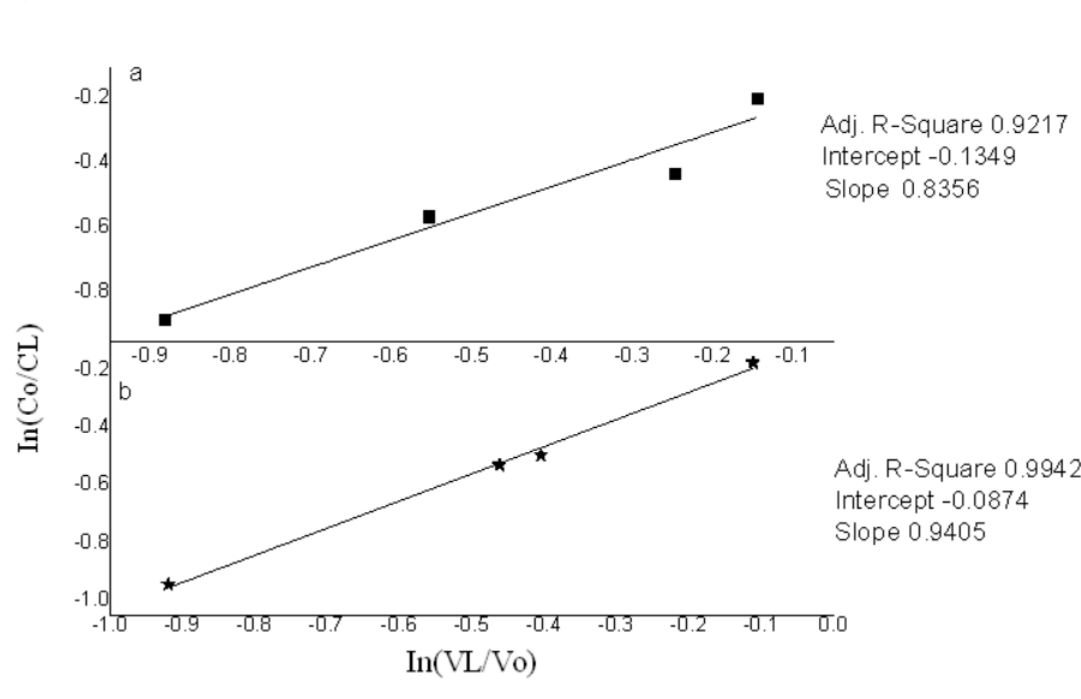
Figure 4. Effect of chloride addition on Cr(VI) removal using freeze desalination at a temperature of 249.15 K: ( a ) deionized water spiked with 5 mg/L Cr(VI), ( b ) deionized water spiked with 5 mg/L Cr(VI), and 250 mg/L Cl −